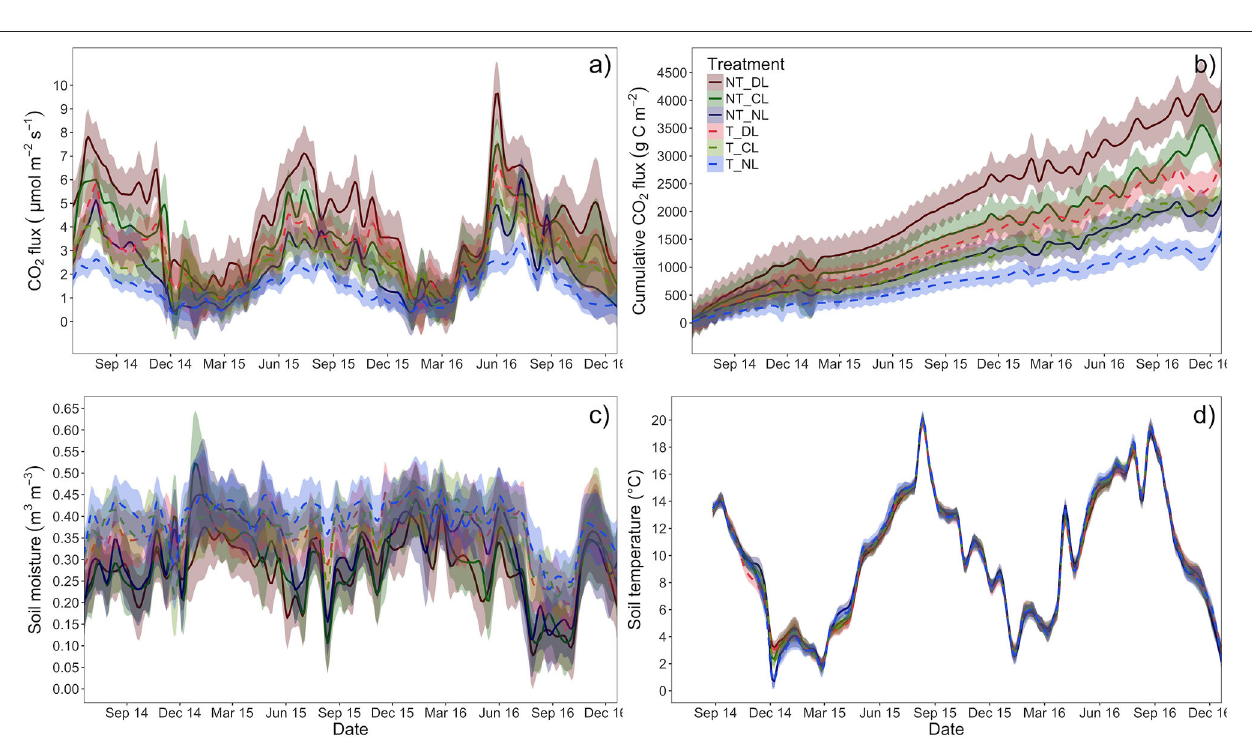
FIGURE 7 | (a) Time course of soil CO 2 fluxes, (b) cumulative soil CO 2 fluxes, (c) soil moisture, and (d) soil temperature in each of the trenching and leaf litter input treatments. Lines represent the loess smooth of n = 5 per treatment and date. Shadowed areas around lines represent the 95% confidence interval of the